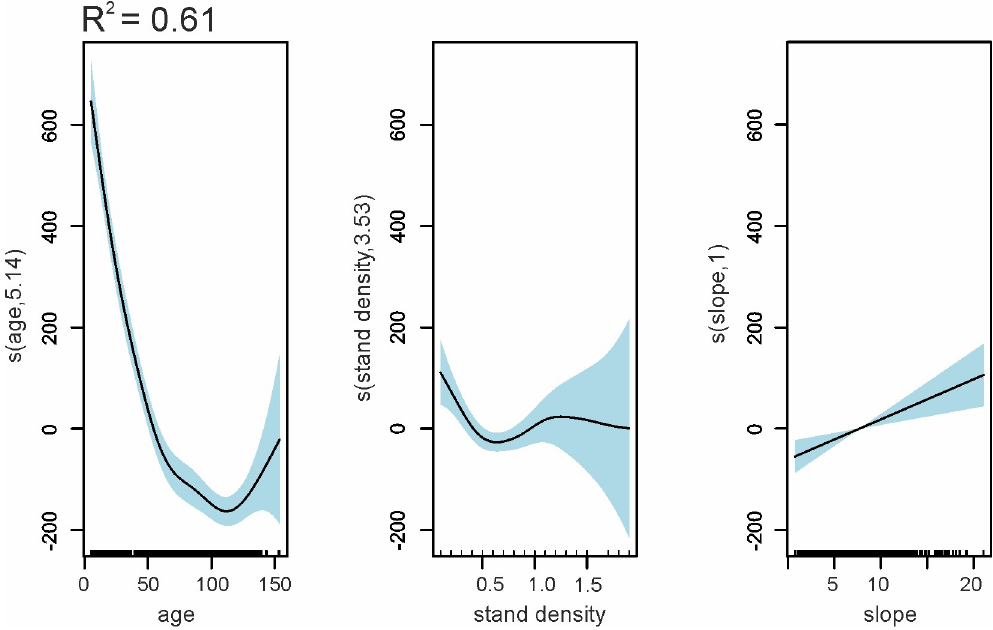
Fig 7. GAMs results–visualization of partial effects on silver fir stands reflectance from predictors—reflectance in NIR1 on April 20 th . The solid line represents the relationship between predictor and response variables, and the light blue shaded area represents confidence